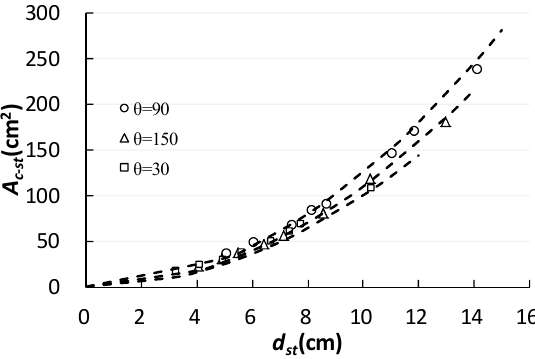
Figure 7. Relation curve of depth and profile area in scour hole.